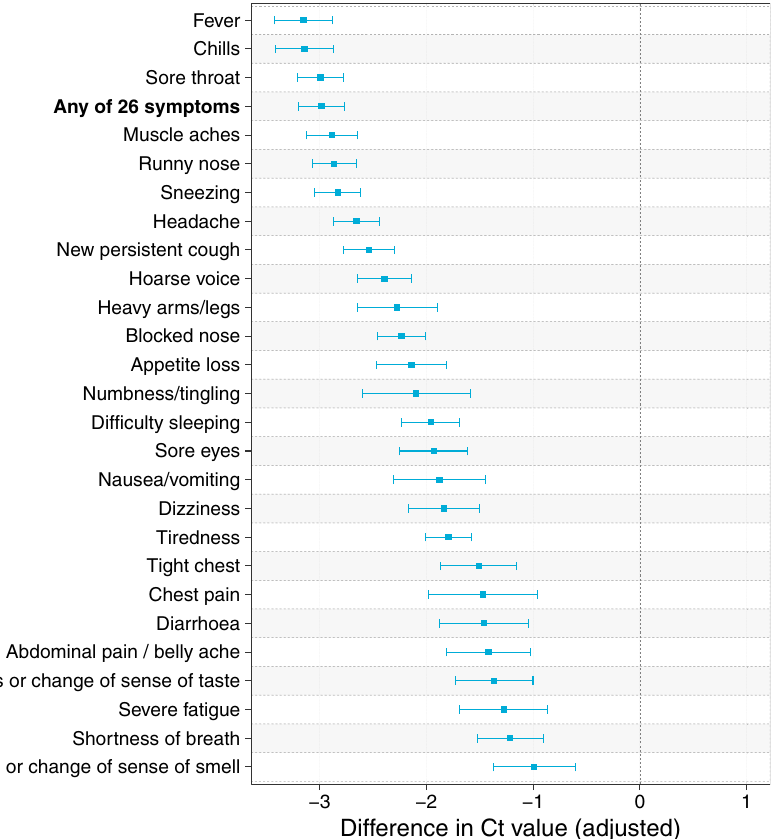
Fig. 5 | Results of linear regression models with N-gene Ct values as the out- come variable and symptoms as individual predictors, adjusted for age, sex and, where appropriate, vaccination status, among N=10,709 swab-positive respondents in rounds 17 – 19 (5January to 31 March 2022). Error bars show 95%